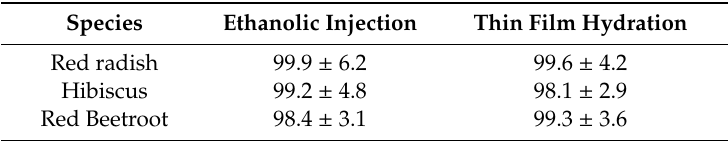
Table 1. Encapsulation efficiency, EE (%) ± SD (%), of extracts in liposomes of soybean lecithin prepared by the two methods (SD: standard deviation).